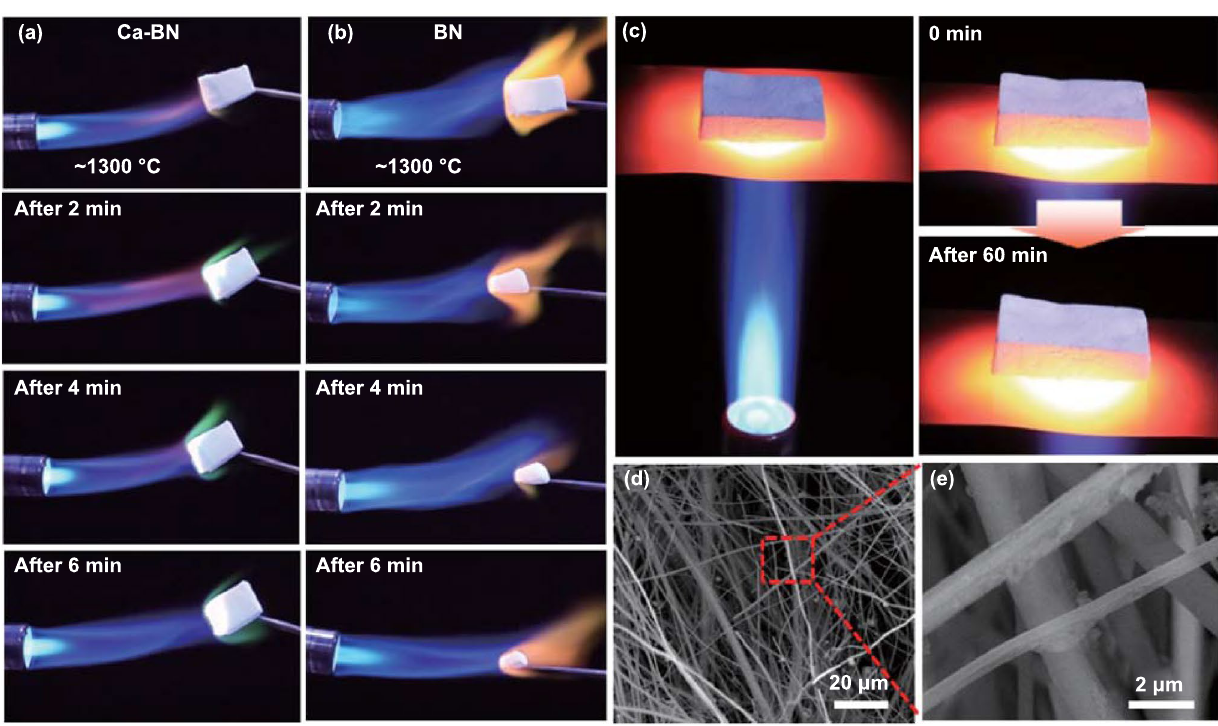
Fig. 3 a – b Optical images of Ca-BN aerogel and pure BN aerogel heated by butane blowtorch flame. c Ca-BN aerogel monolith was placed on the red-hot steel foil which heated by butane flame in air for 1 h. d‑e SEM images of bottom surface after heated for 60